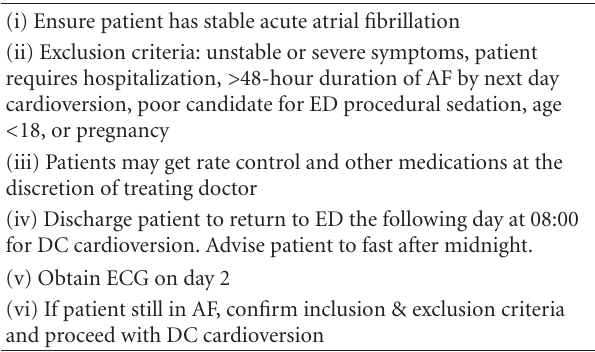
Table 1: Emergency Department protocol for cardioversion of atrial